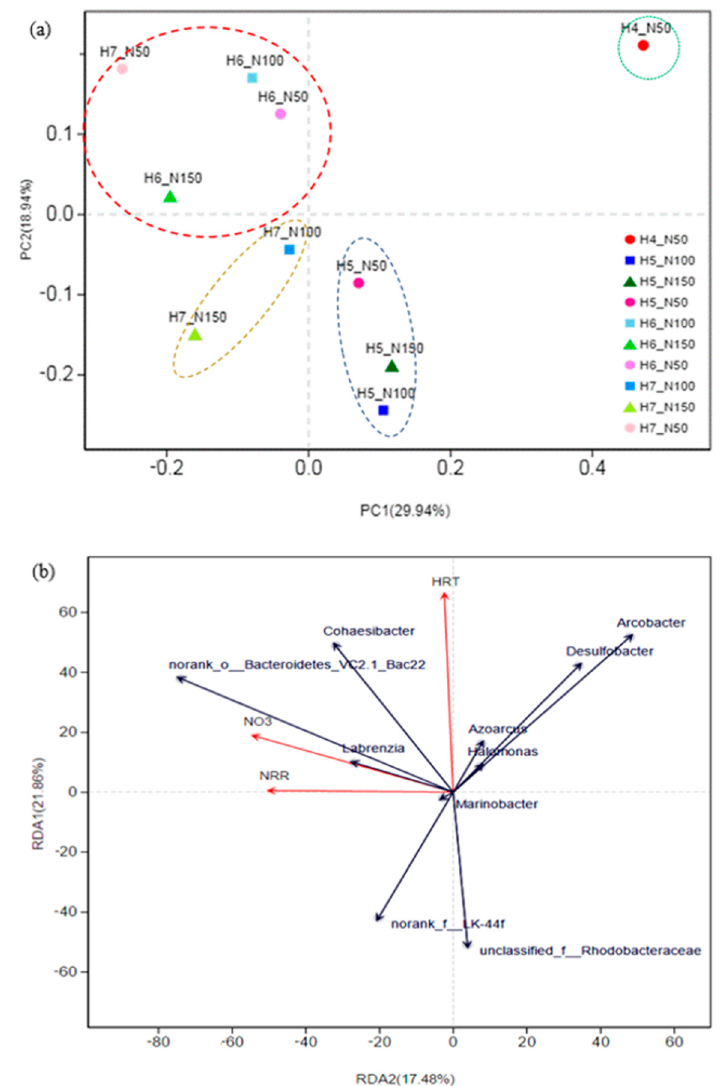
Figure 4. Correlation analysis for microbial communities. ( a ) Principal coordinates analysis (PCoA) of microbial communities of 10 samples. The operational taxonomic units (OTU) were identified by 16S rRNA gene sequencing. Phylogenetic distances between samples were determined using the Bray ‒ Curtis algorithm. ( b ) Redundancy analysis (RDA) illustrating relationships between operational variables (HRT, nitrate concentration, and NRR), and dominant genera.